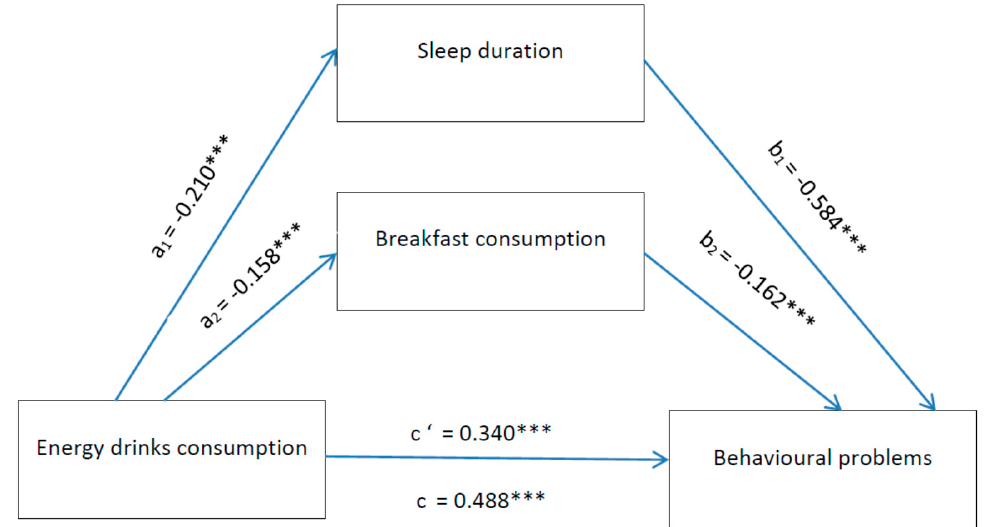
Figure 2. Mediation by sleep duration and breakfast consumption of the relation between EDs and behavioural problems. Notes: *** p < 0.001. All presented effects are unstandardised; a n is the effect of ED consumption on mediators; b n is effect of mediators on behavioural problems; c’ is the direct effect of ED consumption on behavioural problems, and c is the total effect of ED consumption on behavioural problems.